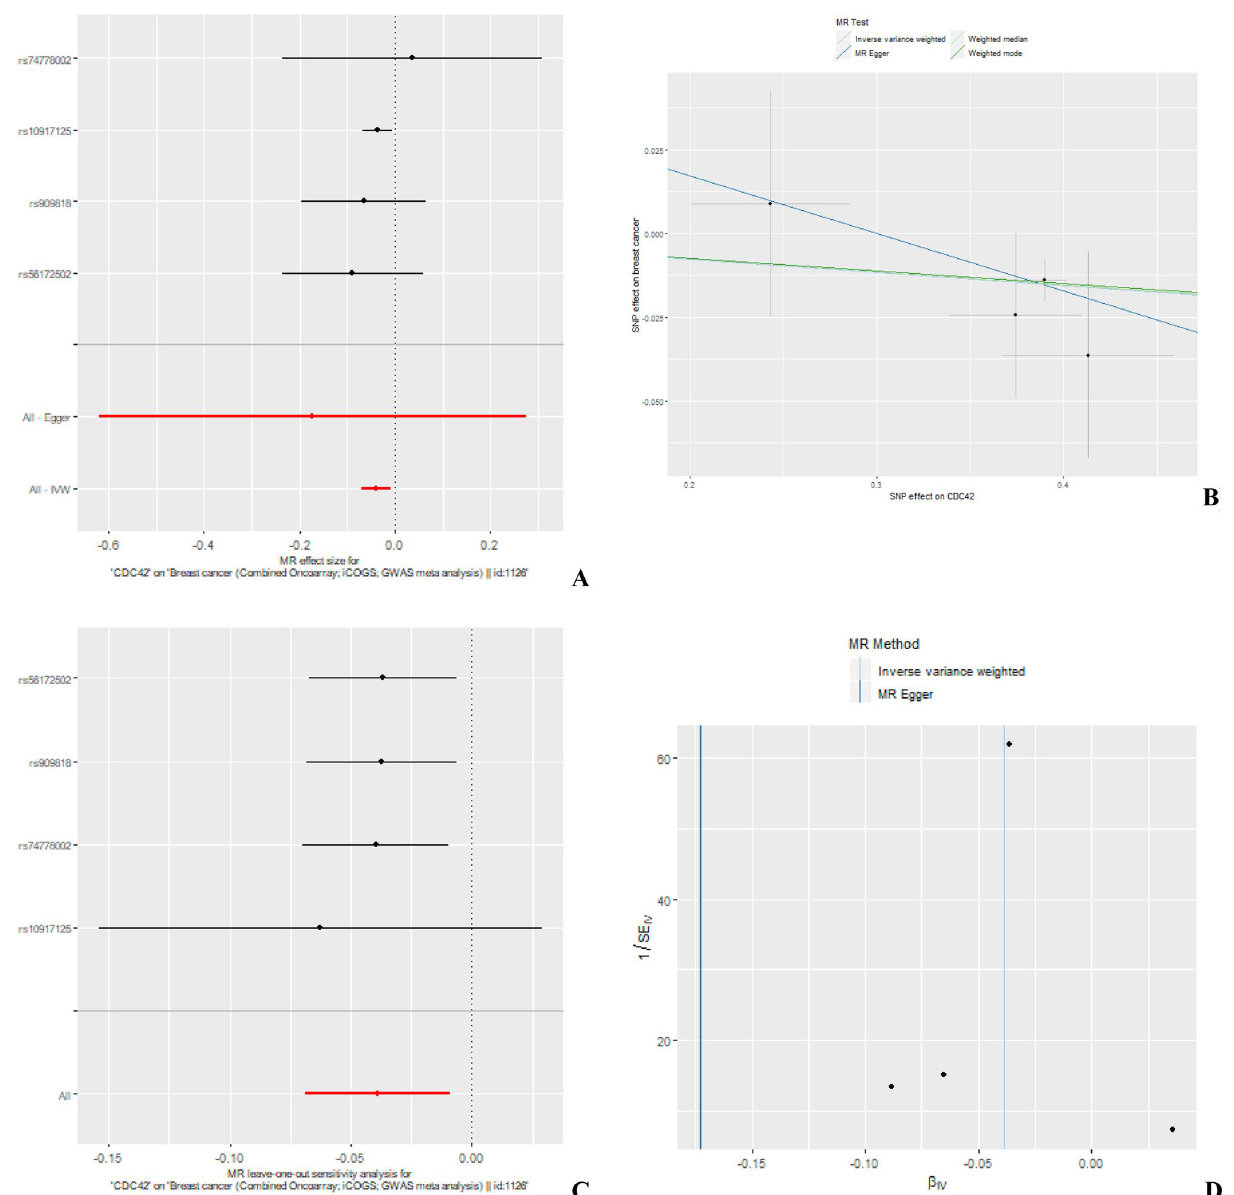
Figure 4. MR results for association between CDC42 and overall breast cancer risk using eQTLs from blood. ( A ) Forest plot of single SNP analysis; ( B ) comparison of results using different MR methods; ( C ) leave-one-out sensitivity analysis; ( D ) funnel plot of IVW and MR-Egger